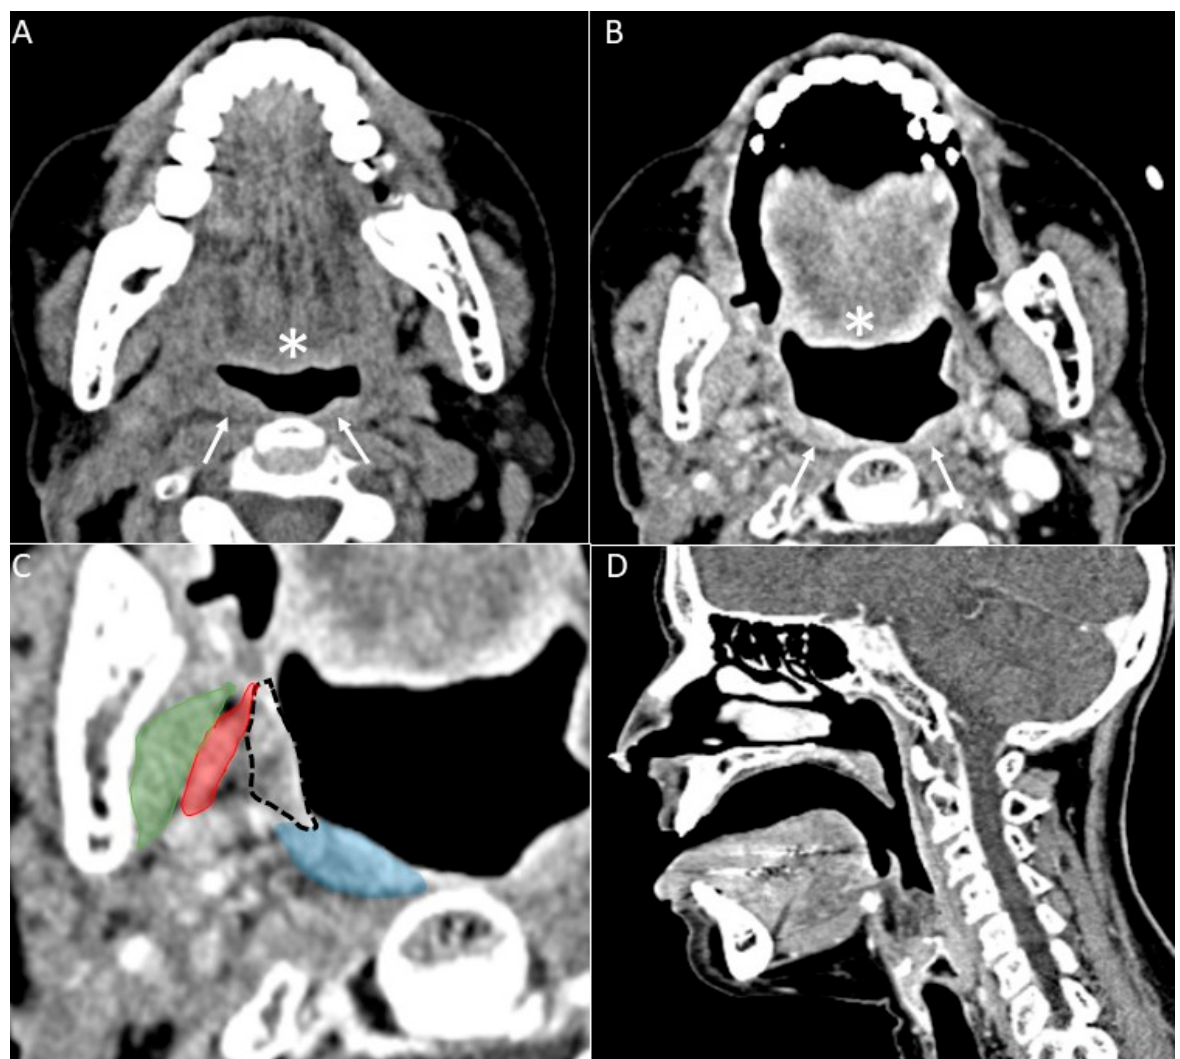
Figure 15. Open mouth with tongue extended MSCT technique. This manoeuvre allows to clearly separate the oral cavity from oropharyngeal structures. ( A ) Axial non-enhanced conventional MSCT acquisition at the level of the tongue base (*) and palatine tonsils (arrows). It is not possible to clearly distinguish the boundaries between the oral cavity and oropharynx making it difficult to assess a possible extension of a tonsillar neoplasm to the tongue base and adjacent muscles (or vice versa, a tongue neoplasm towards the tonsil). ( B ) Axial contrast-enhanced open mouth with tongue extended acquisition at the same level. Tongue and oropharynx with tonsils are “stretched”, isolating these different compartments from each other. ( C ) Detailed image of ( B ) where it is possible to distinguish the palatine tonsil (blue), styloglossus muscle (red), medial pterygoid muscle (green), and glosso-tonsillar sulcus (dotted line). ( D ) Reconstructed sagittal